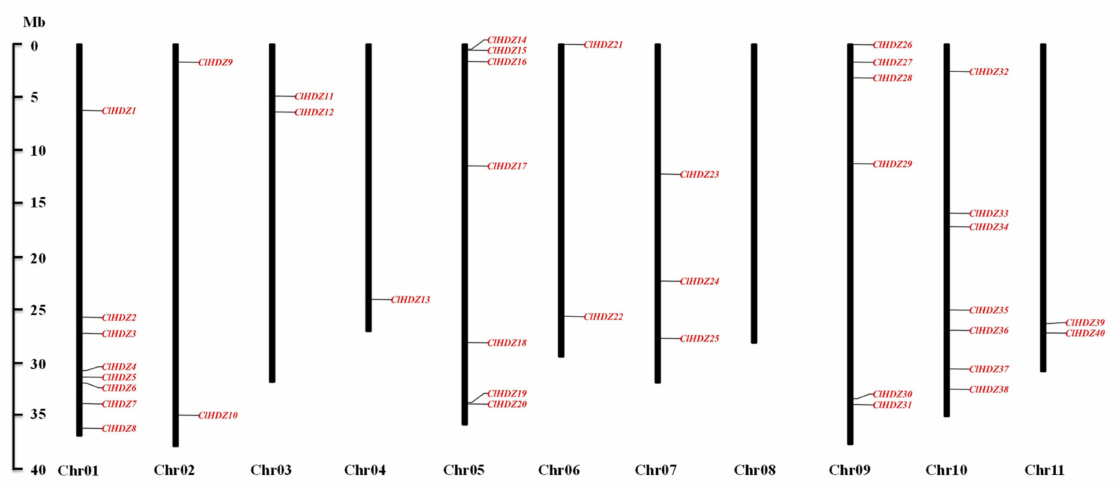
Figure 1. The chromosome distribution of ClHDZs in watermelon.